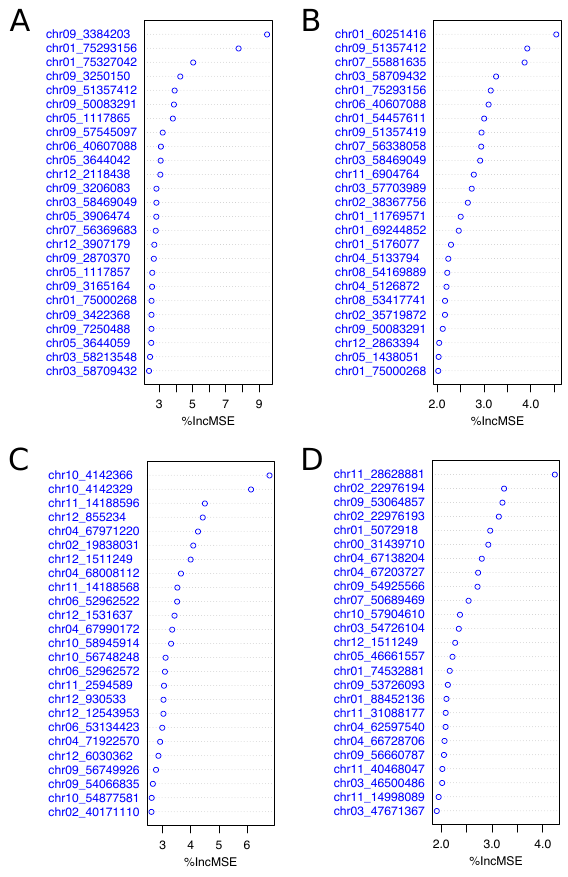
Figure 4. Variable (SNPs) importance measures calculated for fry color ‘off-the-field’ in 2015 ( A ) and 2017 ( C ), and after long-term storage at 4.5 ◦ C in 2015 ( B ) and 2017 ( D ). The x -axis indicates the increase of the Mean Squared Error (MSE) when the SNP is randomly permuted. The top 25 variables are shown. These SNPs were located at 67.97 and 68.00 Mb and are proximal to a tuber-specific